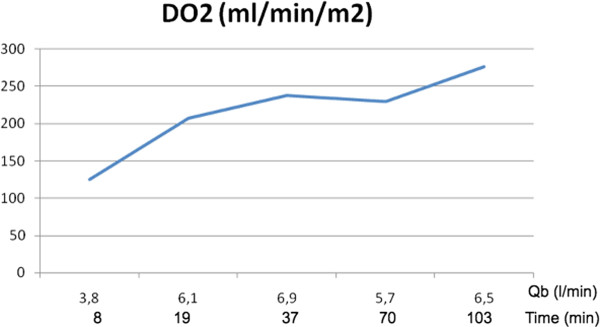
Intra-Operative Oxygen Delivery: (DO2).